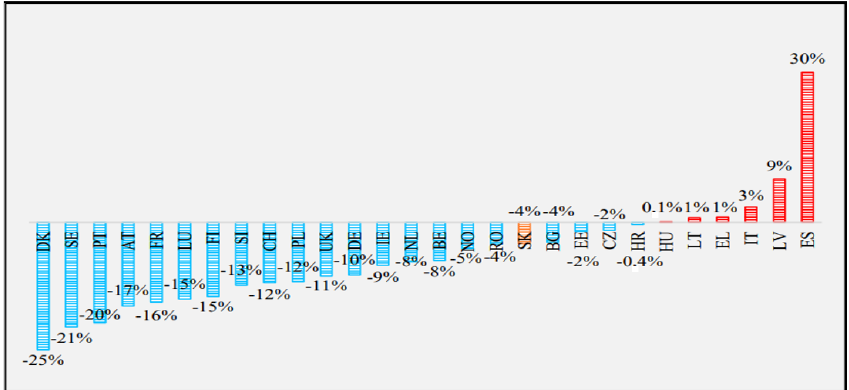
Figure 2. Percentage change in the number of rail crossings in ERA countries between 2011 and 2021 [30].